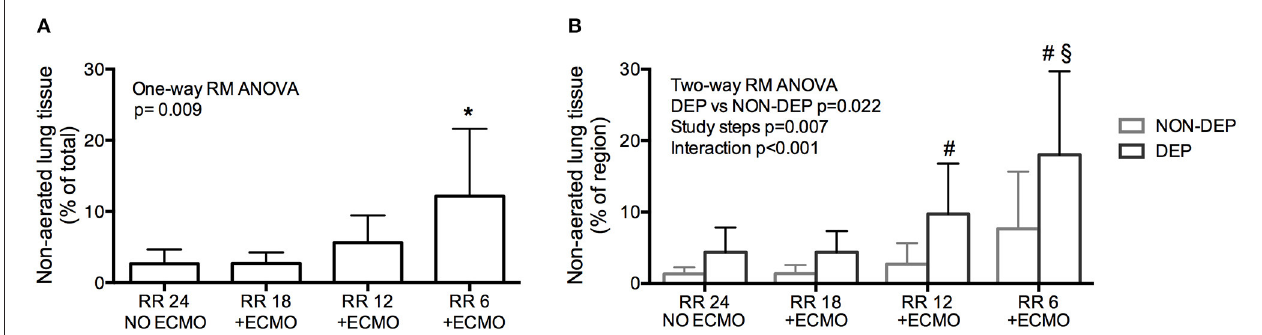
FIGURE 1 | Development of atelectasis (non-aerated lung tissue) in healthy pigs undergoing Extracorporeal Membrane Oxygenation (ECMO) with progressive decrease of respiratory rate. (A) Development of atelectasis as increase of the % of Non-aerated lung tissue. (B) Regional atelectasis as increase of the % of non-aerated lung tissue in gravitationally dependent and non-dependent regions. * p < 0.05 Post-Hoc Holm–Sidak method vs. Baseline. # p < 0.05 Post-Hoc Holm–Sidak method DEP vs. NON-DEP within study steps. § p < 0.05 Post-Hoc Holm–Sidak method vs. Baseline within region